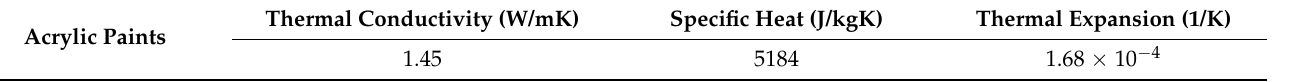
Figure 23. ( a ) Schematic diagram of simulated laser melting of colors. ( b ) 3D heat flux. Table 5. Thermal properties of paints